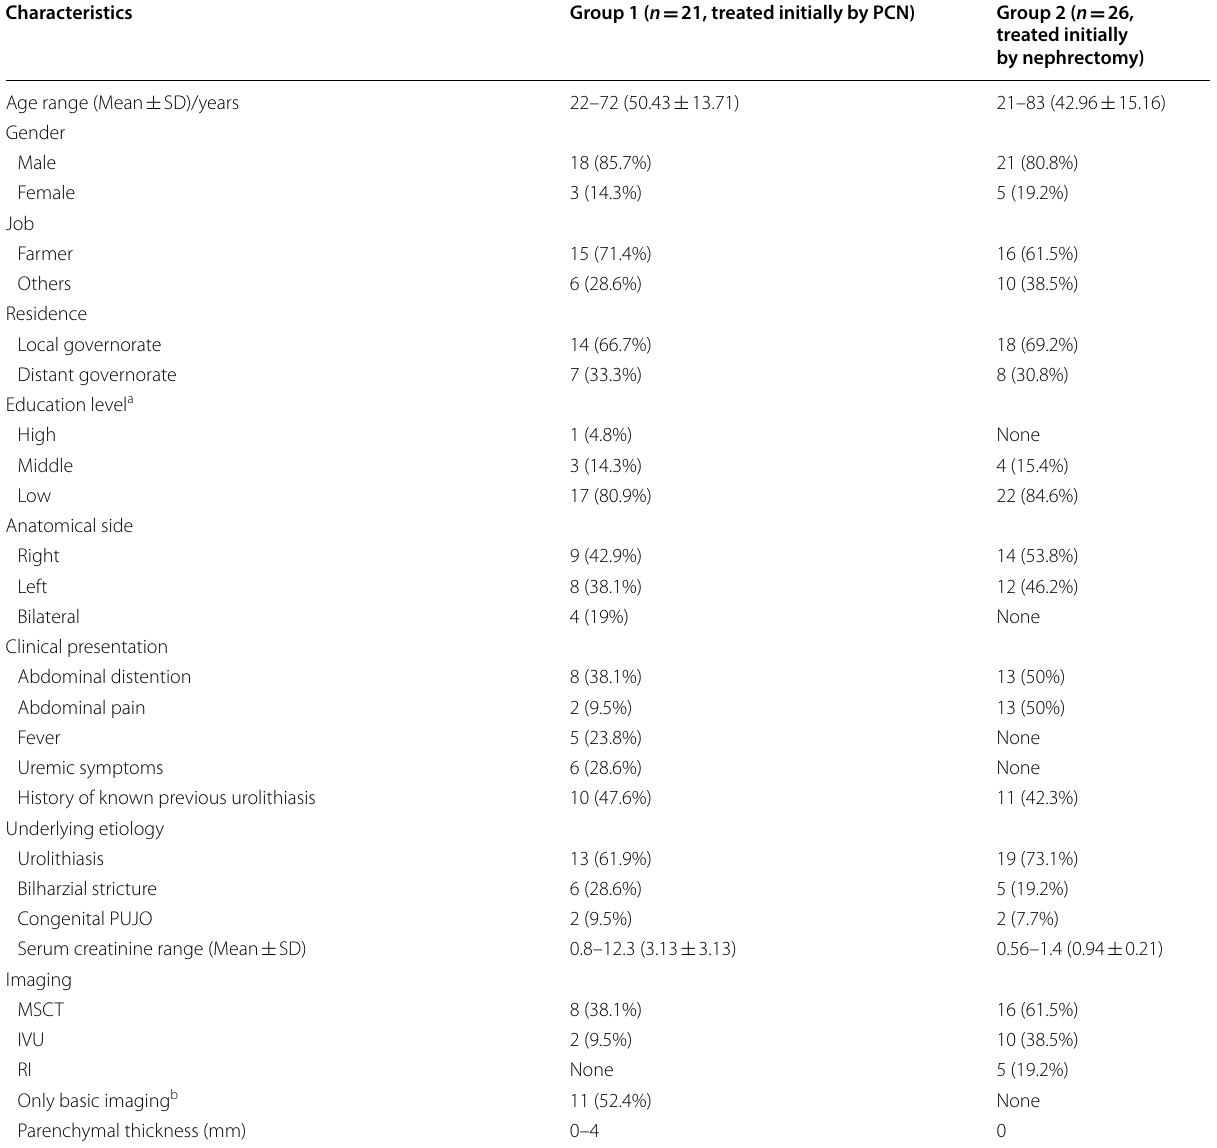
Table 1 Demographic and clinical characteristics of the patients differentiated according to the initial line of treatment into two